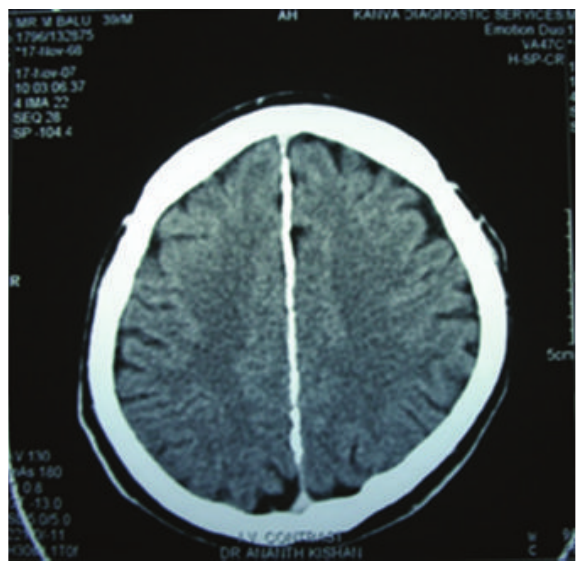
Figure 5: Axial CT of brain showing calcification of falx cerebri.